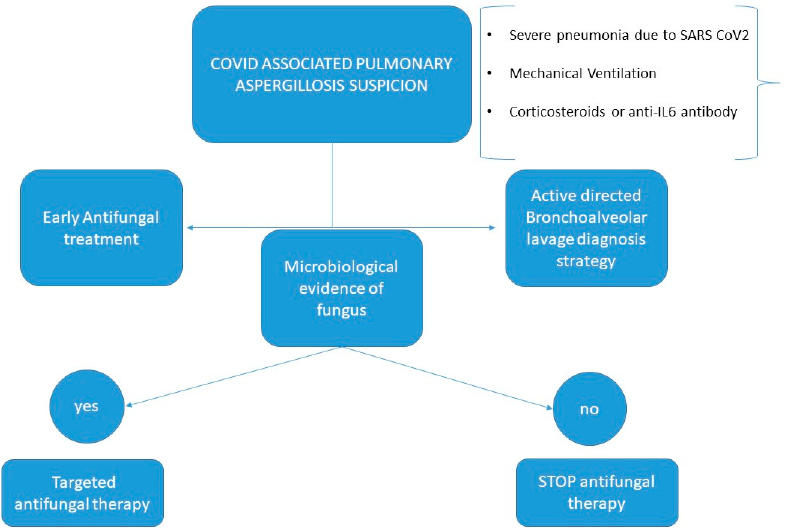
Figure 1. Block diagram showing the algorithm to guide clinical decision during the second period of the study.